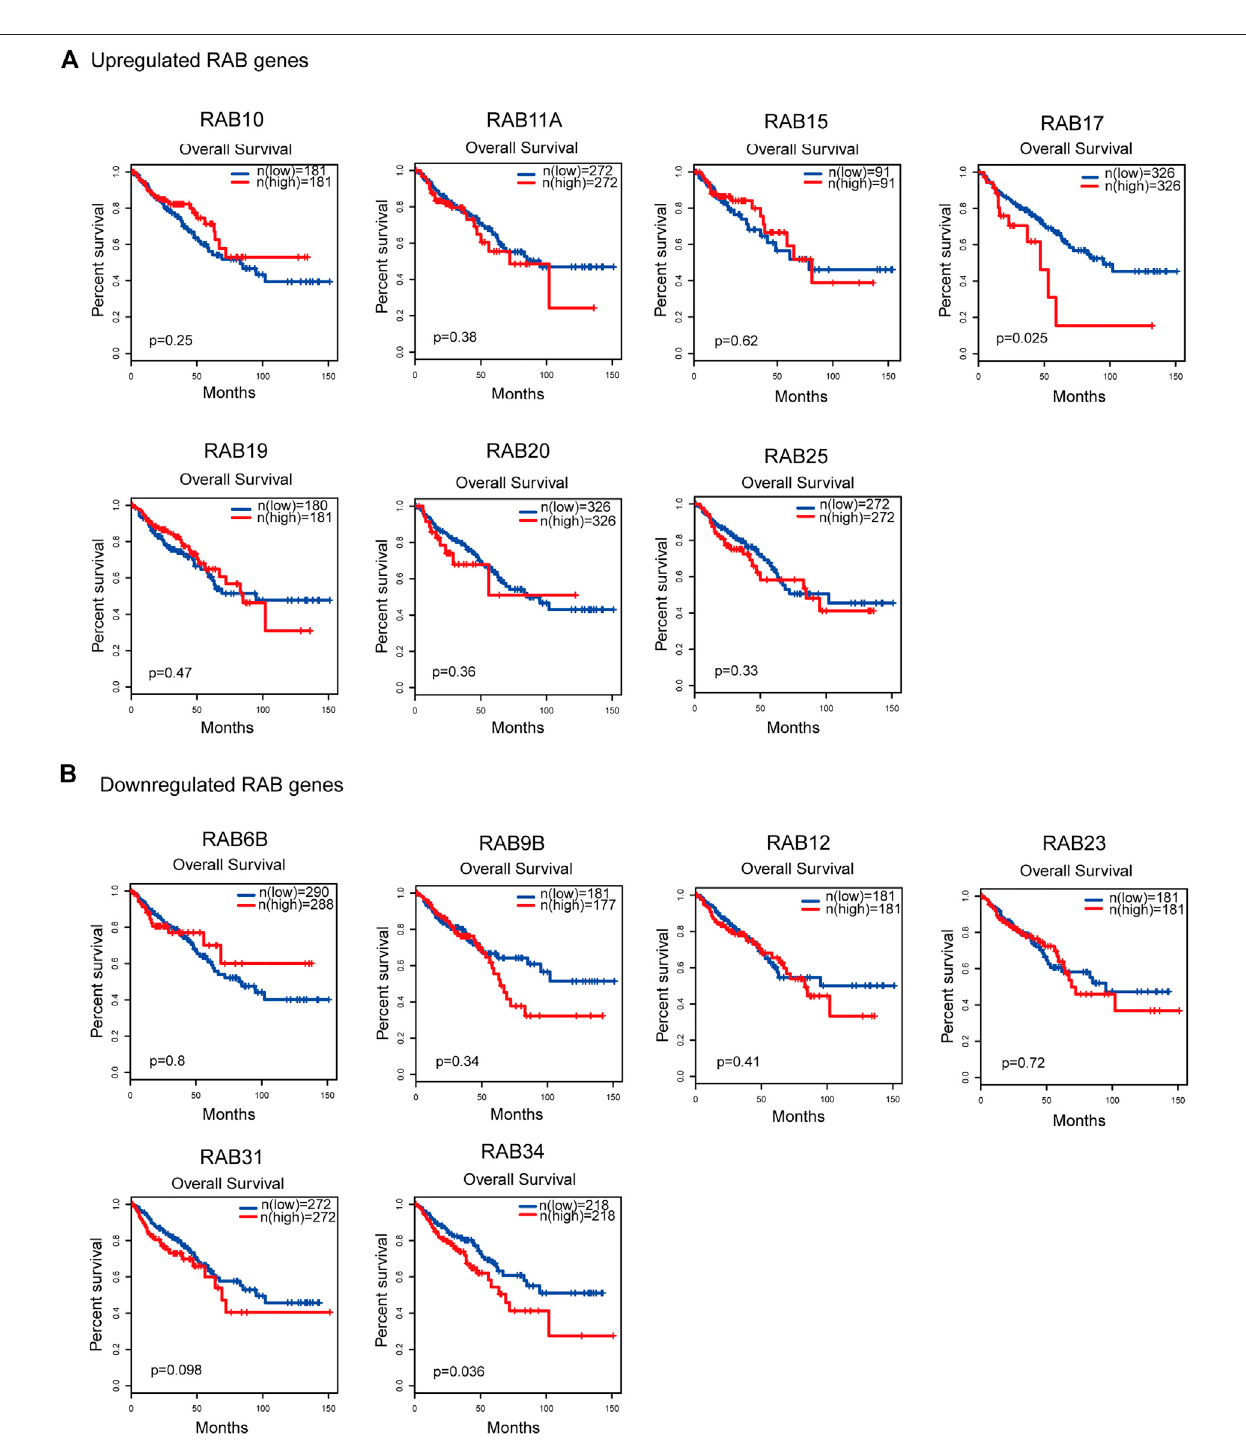
FIGURE 5 | Kaplan – Meier plots for the overall survival of CRC patients strati fi ed by the mRNA expression level of RABs. (A) The overall survival curves of the upregulated-RABs (RAB10, RAB11A, RAB15, RAB17, RAB19, RAB20, and RAB25). (B) The overall survival curves of the downregulated-RABs (RAB6B, RAB9B, RAB12, RAB23, RAB31, and